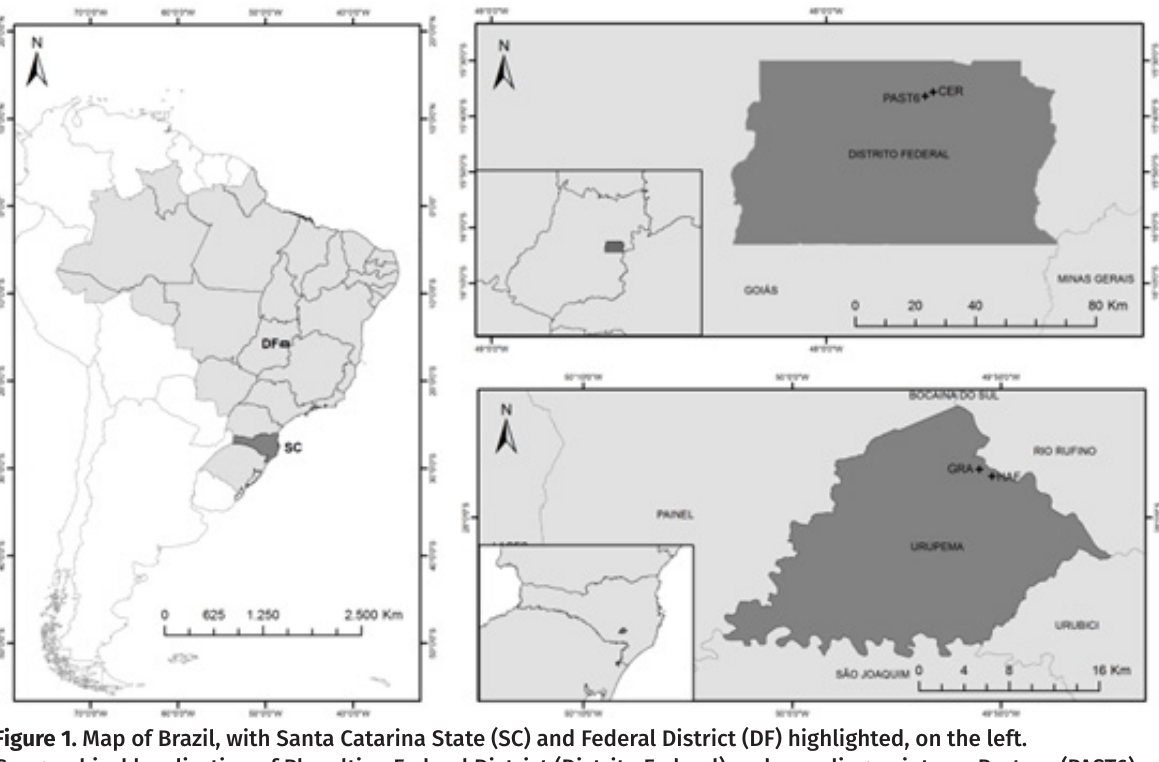
Figure 1. Map of Brazil, with Santa Catarina State (SC) and Federal District (DF) highlighted, on the left. Geographical localization of Planaltina Federal District (Distrito Federal) and sampling points on Pasture (PAST6) and Savanah Tall Woodland (CER) on the upper-right. Geographical localization of Urupema at Santa Catarina State and sampling points on Upper Montane Atlantic Forest (HAF) and grassland (GRA), on the lower